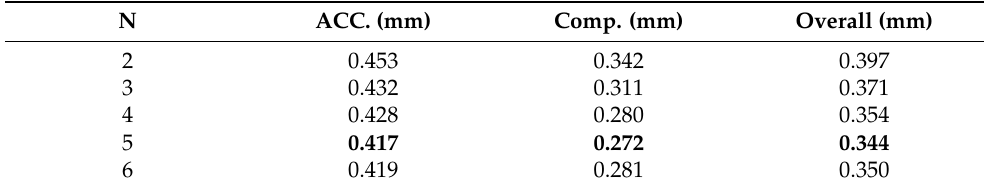
Table 7. Effect of different view numbers on the experimental